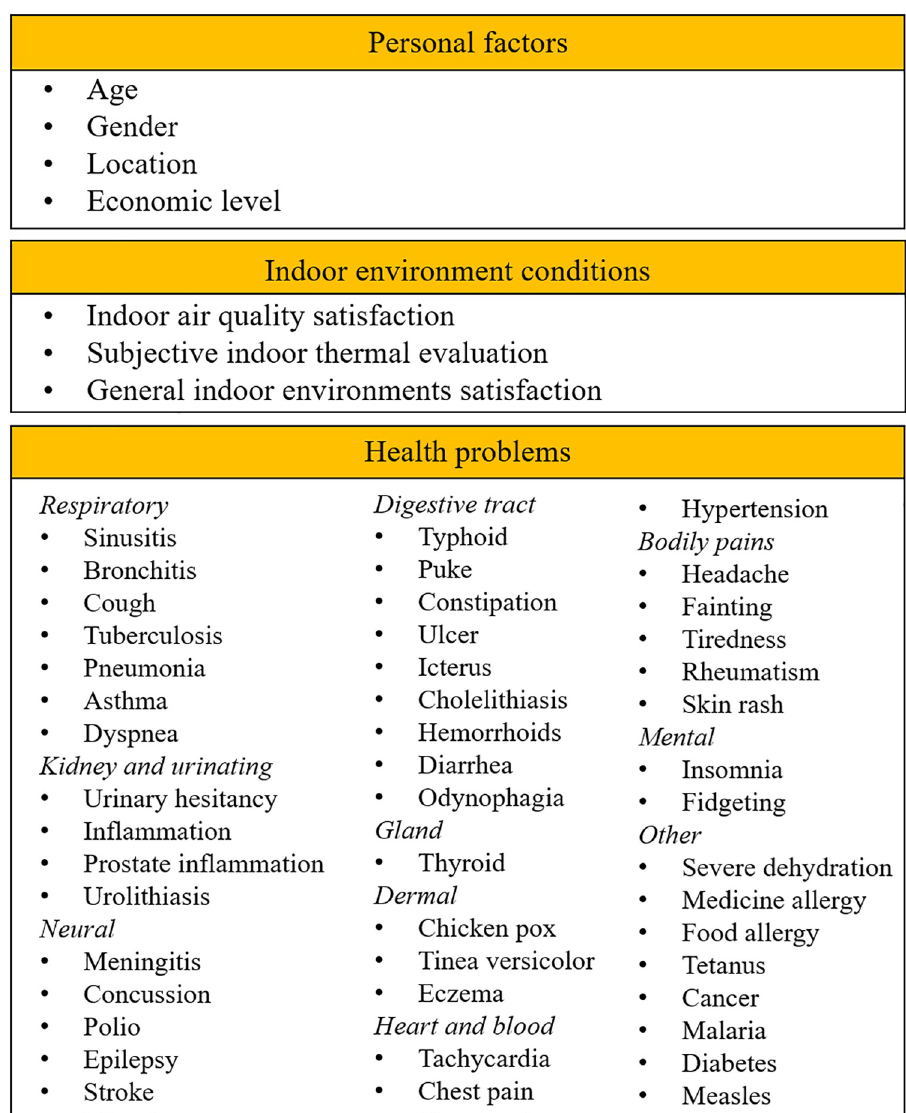
Fig 1. The information collected from the questionnaire